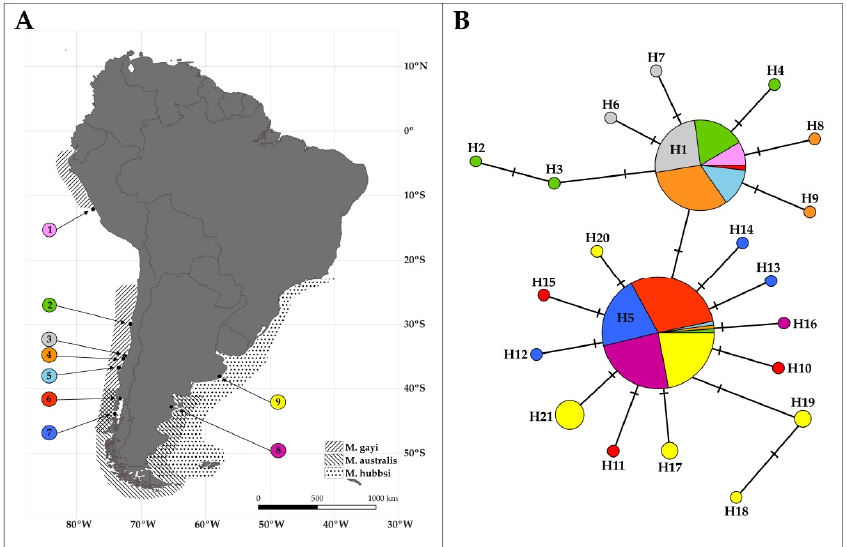
Figure 1. Host distribution in South America (dashed area) ( A ) and mitochondrial cox1 haplotype network showing the 21 haplotypes identified in three species of hakes ( B ). Haplotypes are colored by the locality where the host were obtained. Size of circles is proportional to the number of individuals showing that haplotype. Code for localities: 1 = Callao, 2 = Coquimbo, 3 = Duao, 4 = Constitución, 5 = Talcahuano, 6 = Puerto Montt, 7 = Guaitecas, 8 = Puerto Madryn, 9 = Mar del Plata.